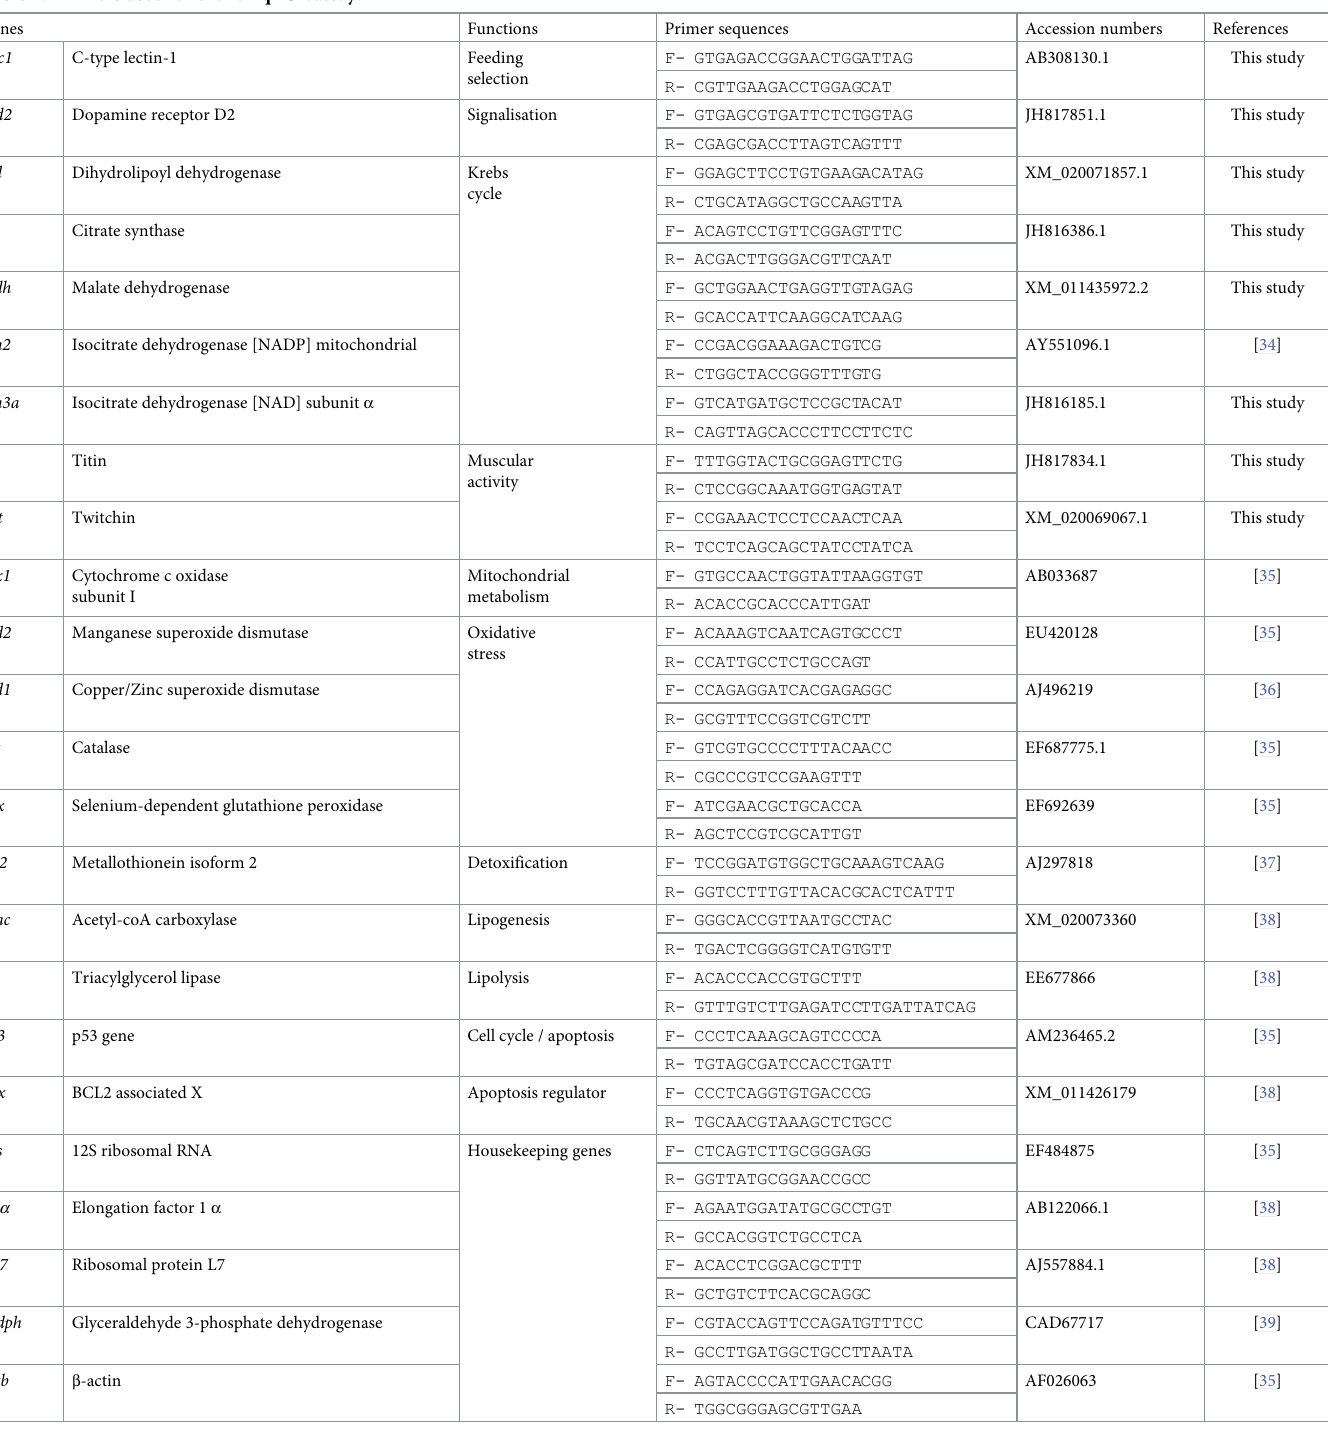
Table 1. Primers used for the RT-qPCR